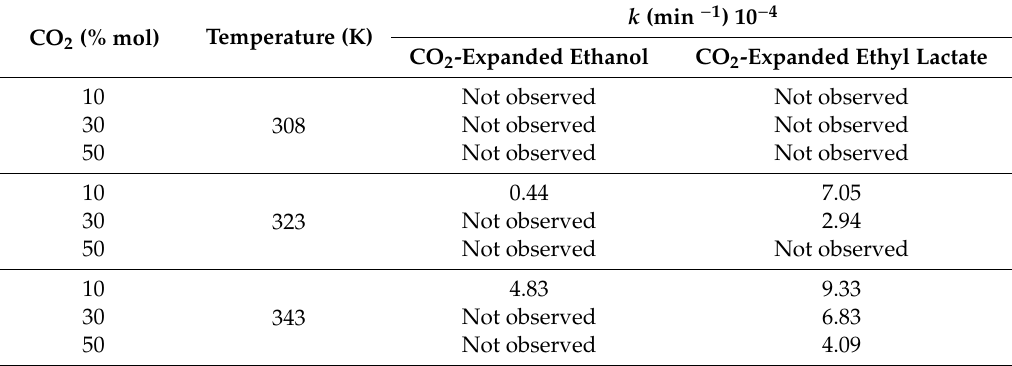
Table 1. E ff ect of temperature and CO 2 concentration on the first order kinetics constant ( k ) for the thermal degradation of quercetin in carbon dioxide expanded liquids (CXLs). “Not observed” means that there was no detected change in quercetin concentration, i.e., no degradation. n = 3. k (min − 1 ) 10 − 4 CO 2 (% mol) Temperature (K) CO 2 -Expanded Ethanol CO 2 -Expanded Ethyl Lactate Not observed Not observed Not 308